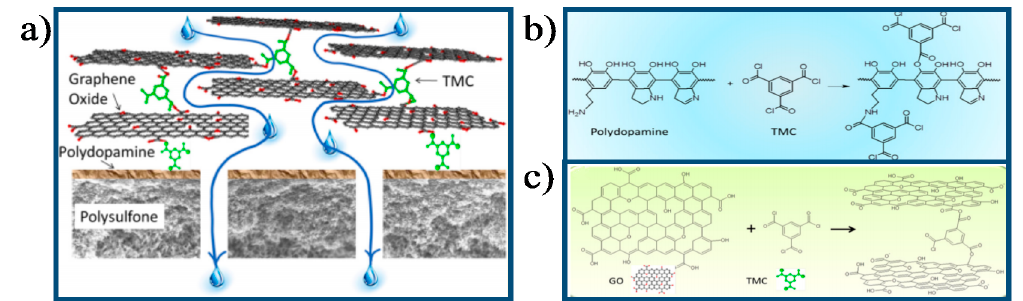
Figure 10. Schematic illustration of ( a ) The forming process of the GO membrane; ( b ) The interaction mechanism between PDA and TMC; ( c ) The interaction mechanism between GO and TMC [26]. Copyright 2013 American Chemistry Society.